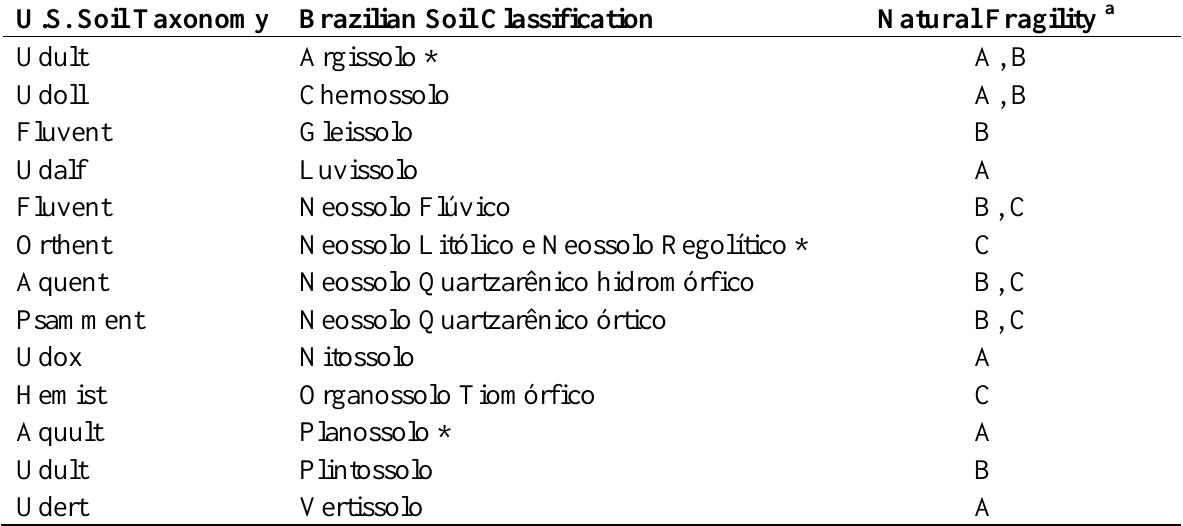
Table 1. Predominant soil classes found in the Brazilian Pampa biome and its respective natural fragility. Adapted from Tornquist et al.